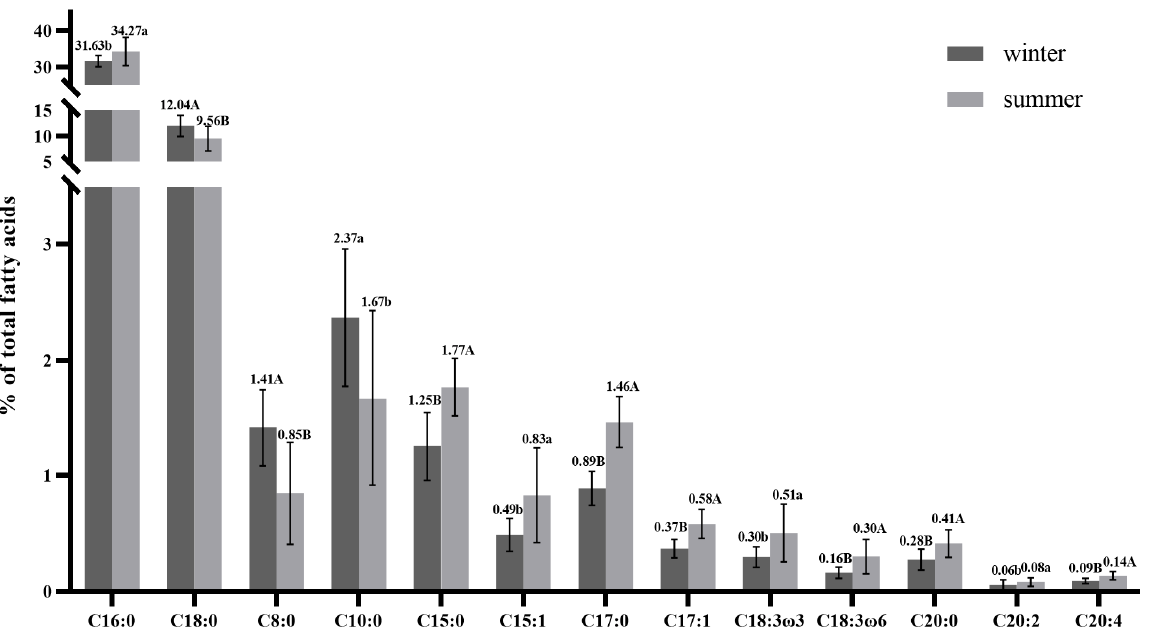
Figure 1. The individual fatty acids have a significant difference in winter and summer of crossbred buffalo raw milk. a, b—values differ significantly between two groups ( p < 0.05); A, B—values differ extremely significantly between two groups ( p < 0.01).